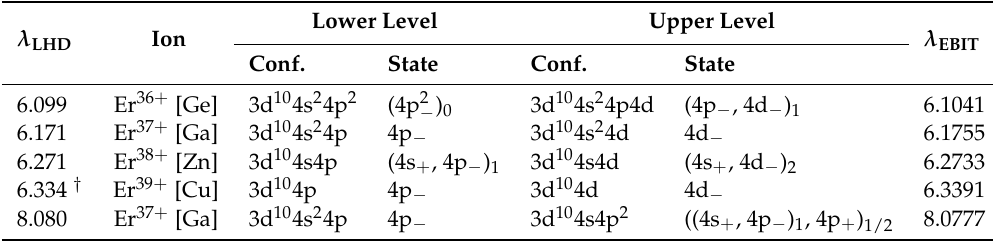
Table 2. The assignments of the lines of erbium ions indicated by arrows in the middle panel of Figure 1. The assignments are based on a comparison with the NIST EBIT data at a beam energy of 2.0 keV [29]. Isoelectronic sequence of each ion is shown in a square bracket. The states of the lower and upper levels are denoted in jj coupling notation. All wavelengths are in